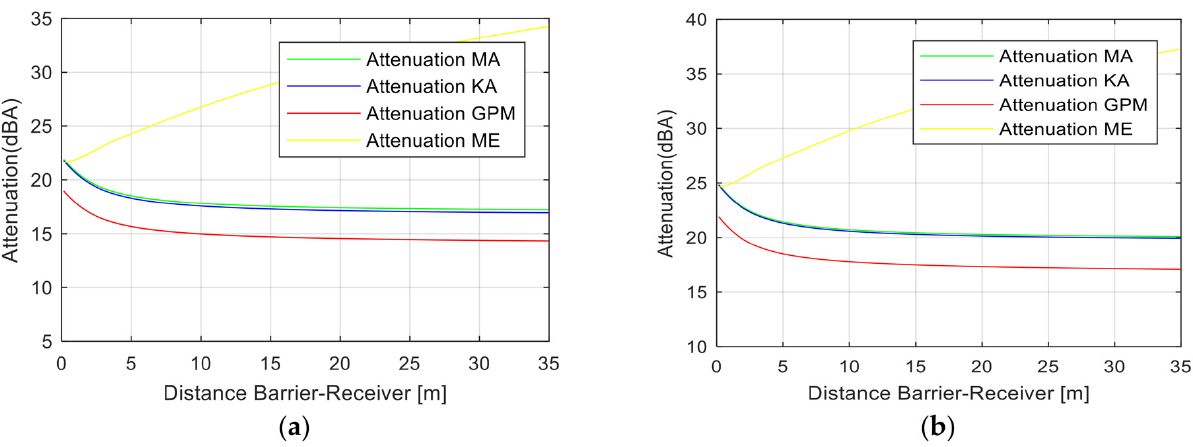
Figure 4. Sound attenuation as a function of the distance barrier-receiver and for a pure tone. ( a ) Frequency = 500 Hz, ( b ) frequency = 1000 Hz.